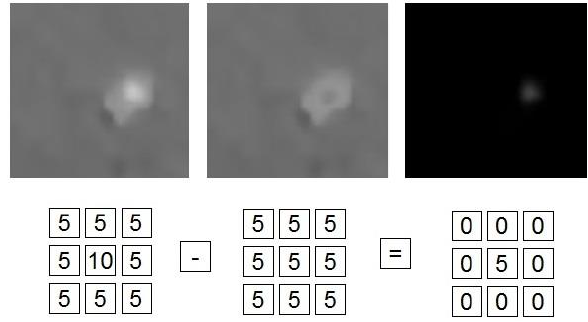
Figure 4. Subtraction of the red channel (left) from all three channels as one grayscale image (middle), resulting in only red parts of the image (right); with corresponding artificial digital number (DN) values for every image.